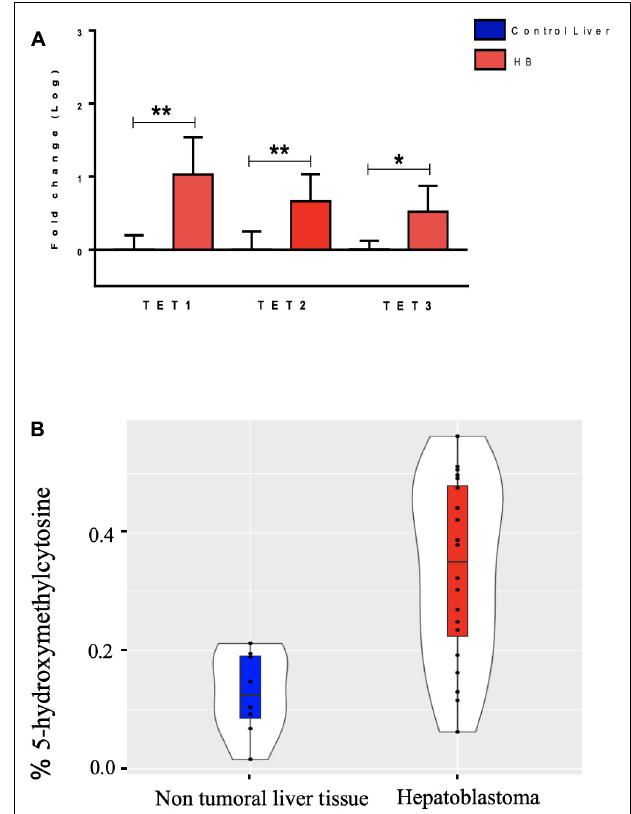
FIGURE 2 | Analysis of DNA hydroxymethylation in hepatoblastomas. (A) Expression analysis of DNA hydroxymethylation genes in hepatoblastomas. Upregulation of three genes of the TET family in 19 tumor samples compared with eight non-tumoral liver samples as evidenced by RT-qPCR. Control Liver: non-tumoral liver tissue samples; HB: hepatoblastoma samples. Endogenous gene: 18S rRNA . The Kruskal Wallis post hoc Dunn test with Bonferroni correction was used for statistical analysis. ∗ p -value < 0.05; ∗∗ p -value < 0.01. (B) 5hmC global level enrichment in hepatoblastoma samples. Violin plots showing the overall level of 5hmC in percentage in hepatoblastomas samples (red) and non-tumoral liver tissues (blue). Hepatoblastoma samples mean: 0.33%, SD: 0.15; non-tumoral liver tissue samples mean: 0.13%; SD: 0.07. The t -test was used for the statistical analysis. p -value: